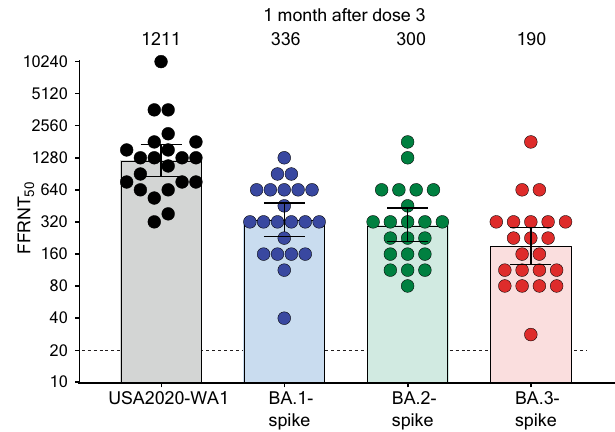
Fig. 1 Serum neutralization of Omicron BA.1-, BA.2-, and BA.3-spike mNG SARS-CoV-2s and USA-WA1/2020 after three doses of BNT162b2. A panel of 22 human sera collected 1 month after dose 3 of the BNT162b2 vaccine were tested for the 50% fl uorescent focus-reduction neutralization titers (FFRNT 50 ) against recombinant USA-WA1/2020 (black circles), Omicron BA.1- (blue circles), BA.2- (green circles), and BA.3-spike (red circles) mNG SARS-CoV-2s. The serum collection scheme is described in Fig. S3 as previously reported 18 . The BA.1-, BA.2-, and BA.3-spike mNG SARS-CoV-2s were produced by engineering the complete Omicron spike genes into the mNG USA-WA1/2020 19 . Each data point represents the geometric mean FFRNT 50 obtained with a serum specimen against the indicated virus, as detailed in Tables S1. The neutralization titers for